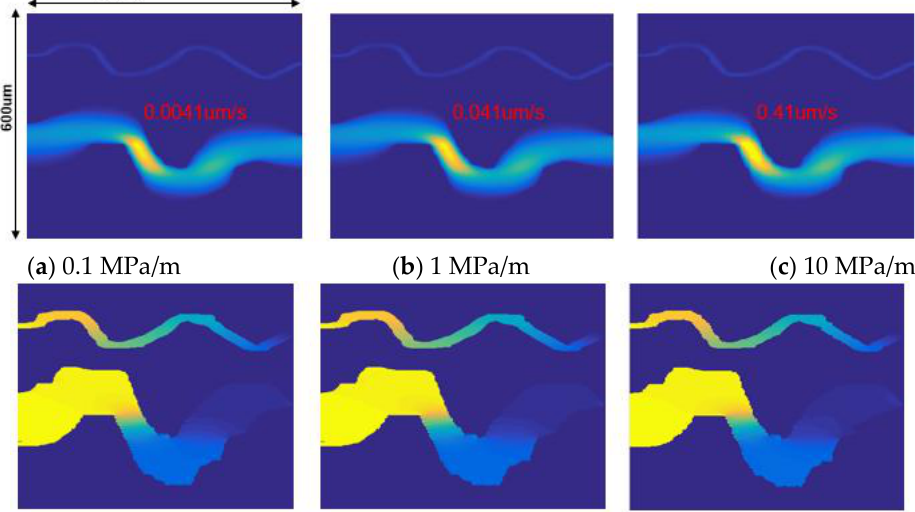
Figure 23. Simulation results of oil in bedding fractures under different pressure gradient condi- tions.